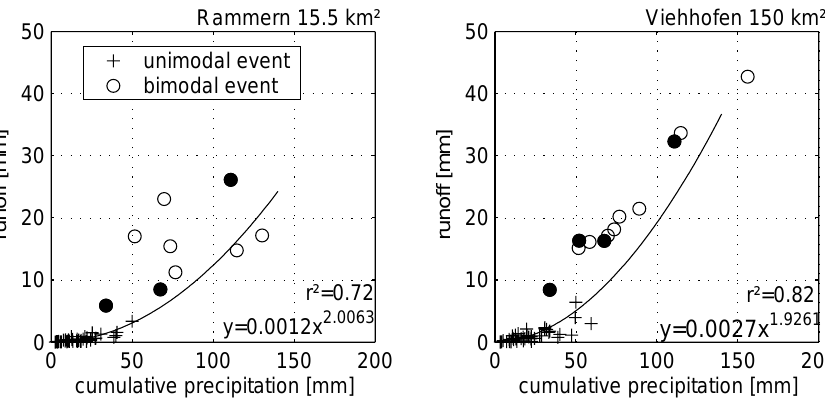
Fig. 13. Runoff versus cumulative precipitation for direct peak events and for bimodal events at two different scales. Total runoff from bimodal events is the runoff from both peaks, filled circles indicate bimodal events with underestimated precipitation due to errors in time